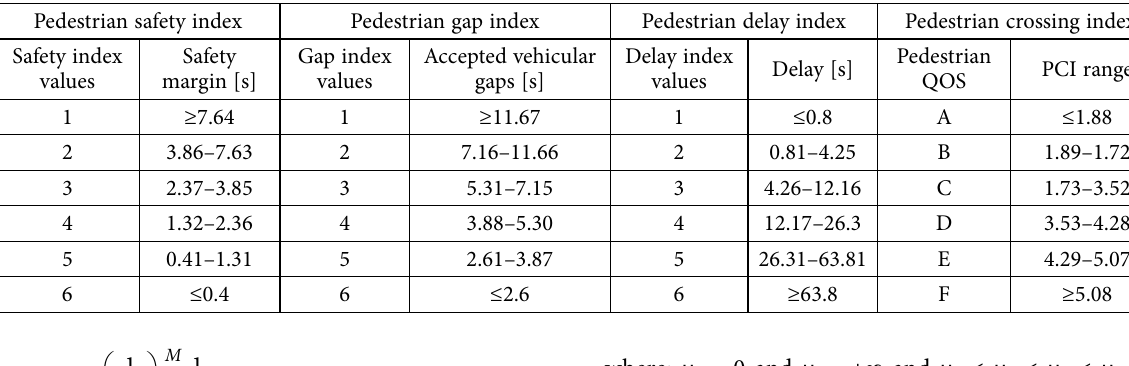
Table 3. Pedestrian safety, gap, delay and crossing index